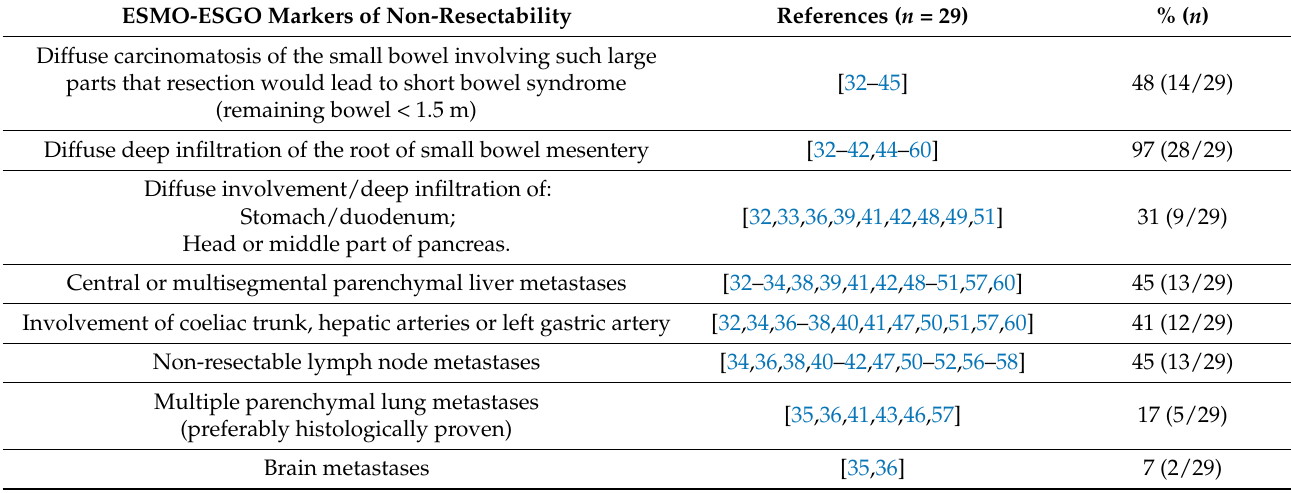
Table 1. ESMO-ESGO markers of non-resectability paired with the data from the literature. ESMO-ESGO Markers of